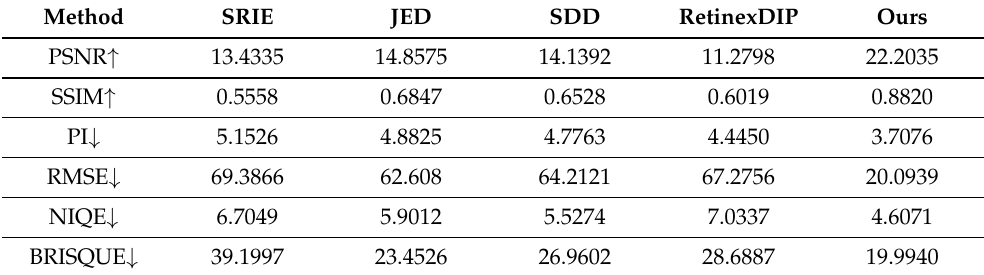
Table 1. Average performance of different enhancement methods in Figure 5.